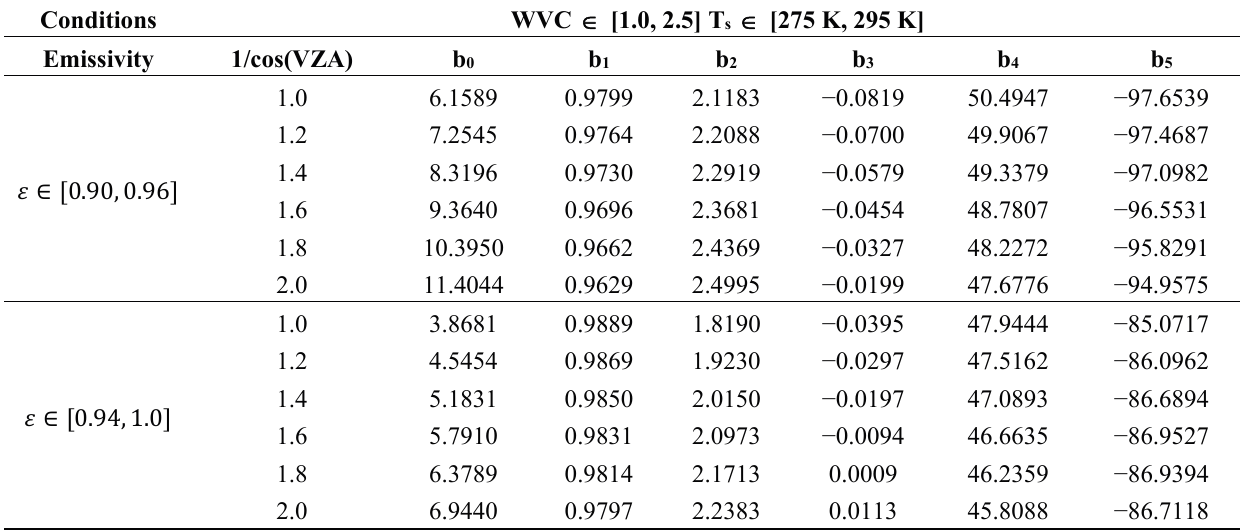
Table 3. Coefficients of the split-window algorithm for the WVC sub-range of 1.0 g/cm 2 to 2.5 g/cm 2 and the LST sub-range of 275 K to 295 K for the two emissivity groups.